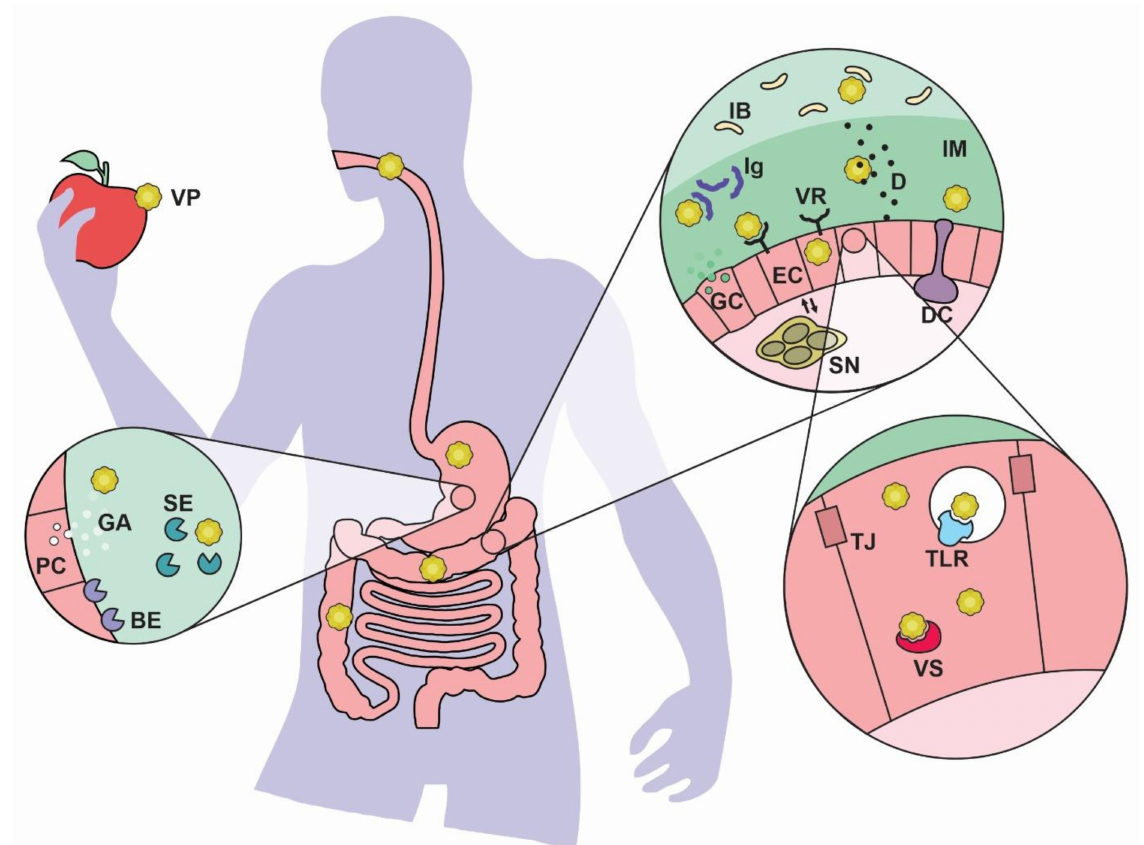
Figure 1. Barriers presented by the host to clear viruses travelling the gastrointestinal tract. Foodborne viruses can encounter diverse obstacles on their way to a target cell. The mouth, stomach and intestine contain physical, chemical and biological barriers that decrease viral count in the lumen and reduce accessibility to its target. In addition, intracellular antiviral mechanisms are designed to destabilize the virus and neutralize its ability to replicate. BE: brush border enzymes, D: defensins, DC: dendritic cell, EC: enterocyte, GA: gastric acid, GC: goblet cell, IB: intestinal bacteria, Ig: immunoglobulin, IM: intestinal mucus, PC: parietal cell, SE: soluble enzymes, SN: submucosal neurons, TJ: tight junction, TLR: toll-like receptor, VP: viral particle, VR: viral receptor, VS: viral